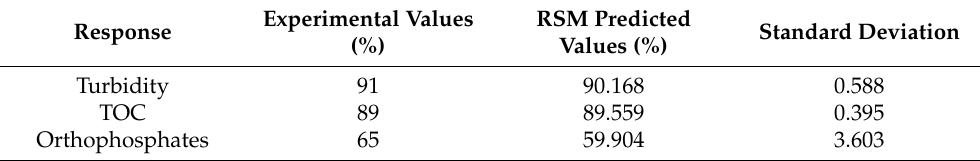
Table 5. Model prediction response values versus experimental values at optimum conditions.